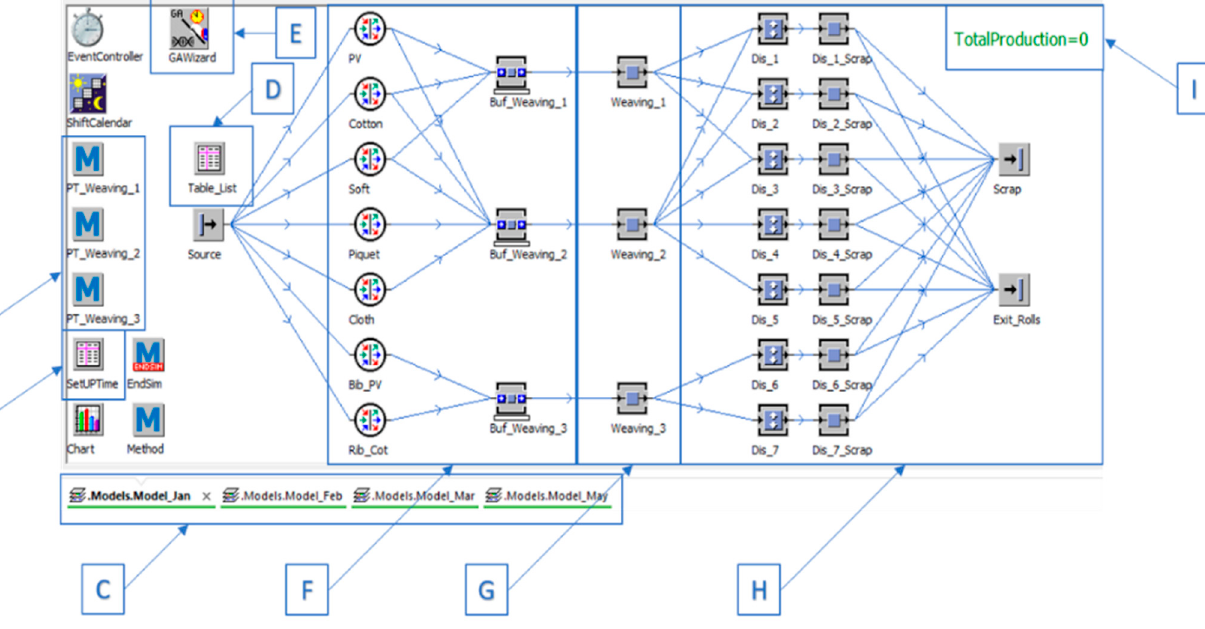
Figure 3. Simulation model.